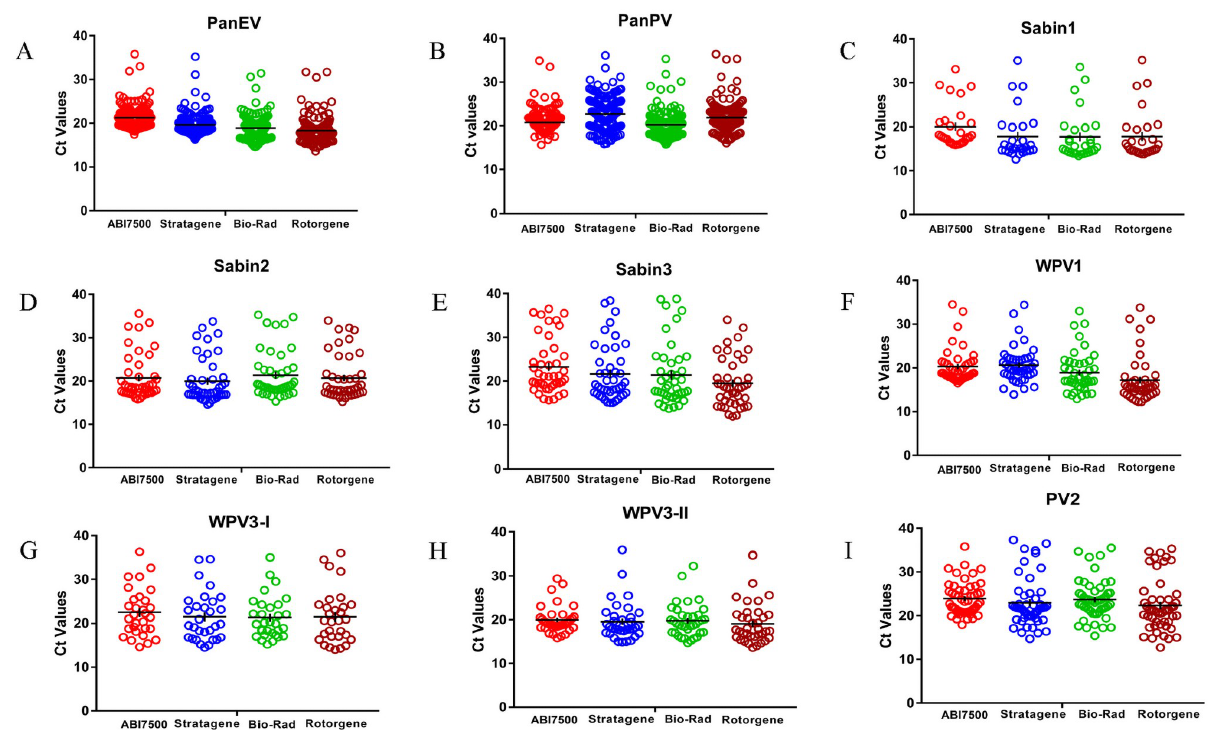
Fig 1. ITD 5.0 Assay results for stratagene (Mx3005P), ABI7500, bio-rad (CFX96) and Rotor-Gene Q (Qiagen). Assay performance against a standard virus panel (N = 184). (A) PanEV assay, 171 of 184 isolates; (B) Pan PV assay, 158 of 184 isolates; (C) Sabin 1 assay 28 of 184 isolates; (D) Sabin 2 assay 44 of 184 isolates; (E) Sabin 3 assay 43 of 184 isolates; (F) WPV1 assay 44 of 184 isolates; (G) WPV3-I assay 30 of 184 isolates; (H) WPV3-II assay 36 of 184 isolates; and (I) the PV Type 2 assay 50 of 184 isolates. The PanEV assay targets the 5’NTR, all other assays target the VP1 capsid region. The WPV3-I and WPV3-II assays target the WPV3 WEAF-B and SOAS variants, respectively.